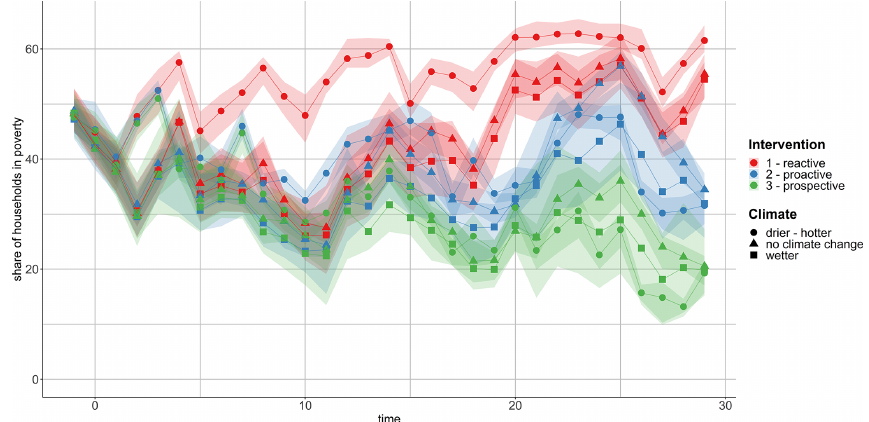
Figure 7. Share of households in poverty (earning under the USD2 per day income line, under different climate and policy intervention scenarios). The shaded area indicates the variation – uncertainty introduced by different model initializations and by the different relative importance of the PMT factors for the decisions of households (sensitivity